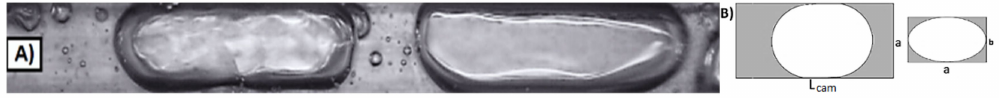
Figure 6. ( A ) Actual and ( B ) approximated shapes of vapor bubbles in longitudinal and transverse sections of the channel with flow direction, case II. Water, T in = 55.2 ◦ C, T out = 125.9 ◦ C, p in = 1.0697 bar, ∆ p = 0.0016 bar, q = 260.1 kW / m 2 , G = 8.6 kg / (m 2 s), Re = 66.9, L